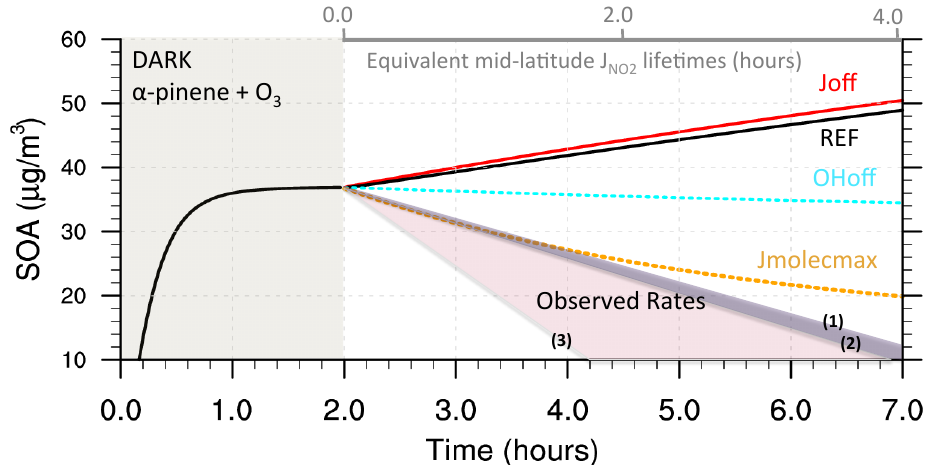
Figure 6. GECKO-A simulation of a typical SOA aging experiment. SOA is first made in the dark in 2h from α -pinene ozonolysis in the conditions where the formation of hydroperoxides dominates (through RO 2 + HO 2 reactions). After the second hour the initial precursor has been consumed, and the SOA mixture is exposed to various conditions: (REF, black) UV black lights and OH of 10 6 moleculescm − 3 , ( J off , red) only OH oxidation with OH = 10 6 moleculescm − 3 and photolysis are turned off for organic compounds, (OH off , cyan blue) only UV black lights, and ( J molecmax , orange) similar to the REF case but with the photolysis of organic molecules also performed in = 3 × 10 − 3 s − 1 ; during the ageing simulations, NO x levels the condensed phase. The UV lamp is that of Presto et al. (2005), with J NO 2 are kept at 0.01ppb, ozone levels are set at 50ppb, and HO 2 levels are predicted to range between 1.2 × 10 8 moleculescm − 3 ( J off ) and 2 × 10 8 moleculescm − 3 (REF). SOA loss rates reported in the experiments are also shown in shaded purple areas with slopes corresponding to (1) Henry and Donahue (2012) (6 × 10 − 5 s − 1 ), (2) Wong et al. (2014) for dry conditions (7.9 × 10 − 5 s − 1 ) and (3) Wong et al. (2014) for humid conditions (1.6 × 10 − 4 s − 1 ). Table 4. Estimated loss rates and lifetimes due to gas-phase and in-particle phase photolysis as predicted by GECKO-A for the J